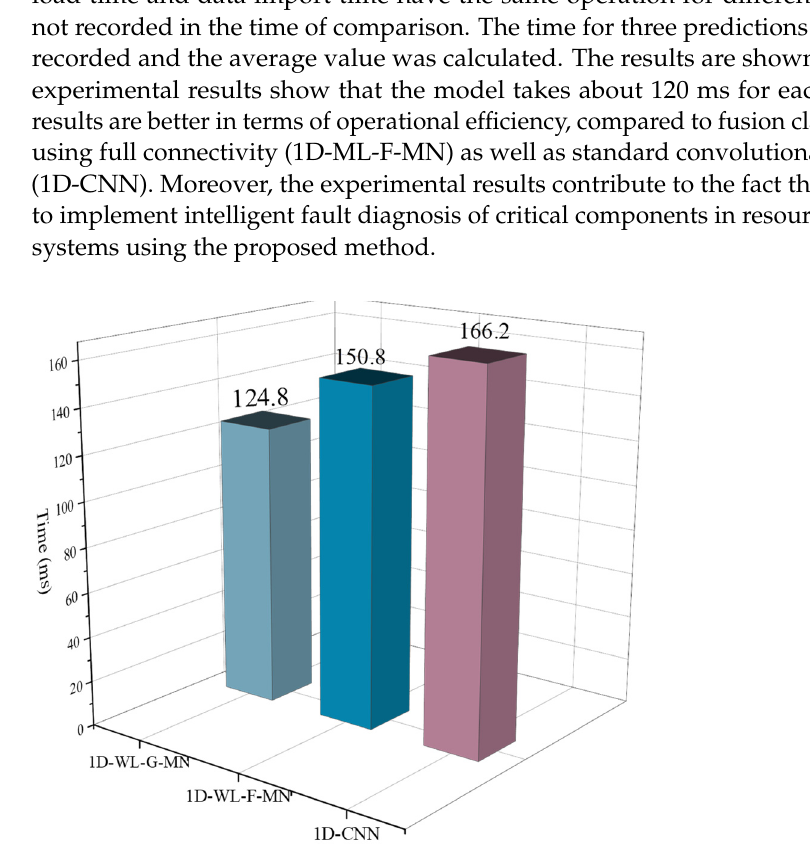
Figure 16. Running time in Raspberry Pi